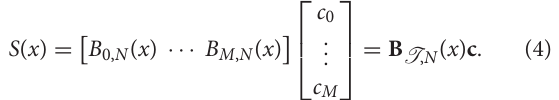
FIGURE 1 | The B-spline basis terms (Equation 2) are compactly supported. Shown are the basis terms for orders N distributed uniformly: t i B-spline basis terms,